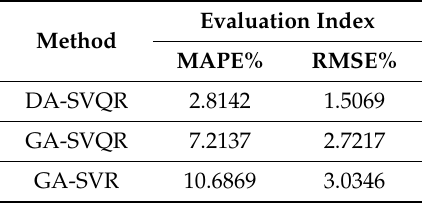
Table 2. Prediction error of dragonfly algorithm (DA)-SVQR, genetic algorithm (GA)-SVQR and GA-support vector regression (SVR) methods.